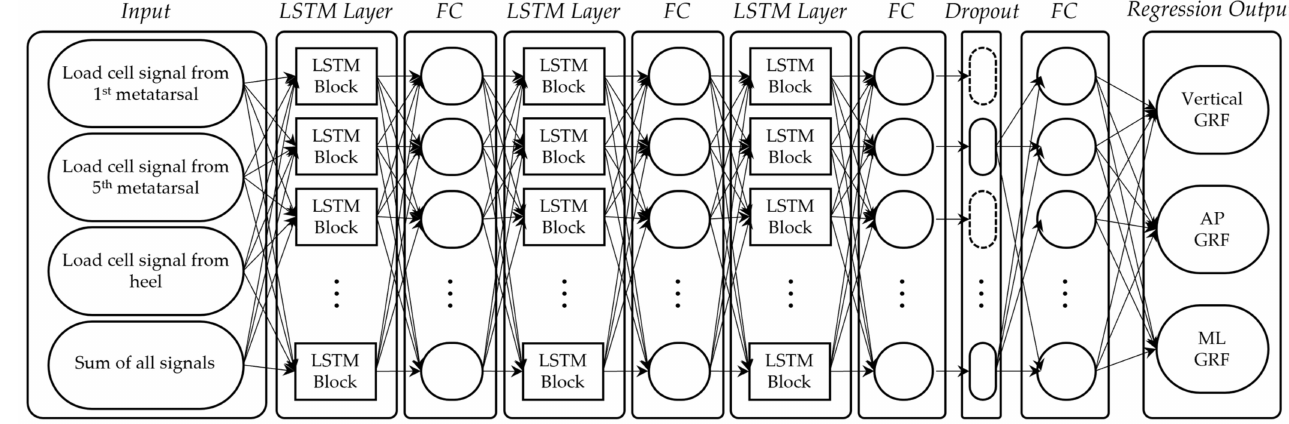
Figure 3. Seq2seq LSTM layer to estimate 3D